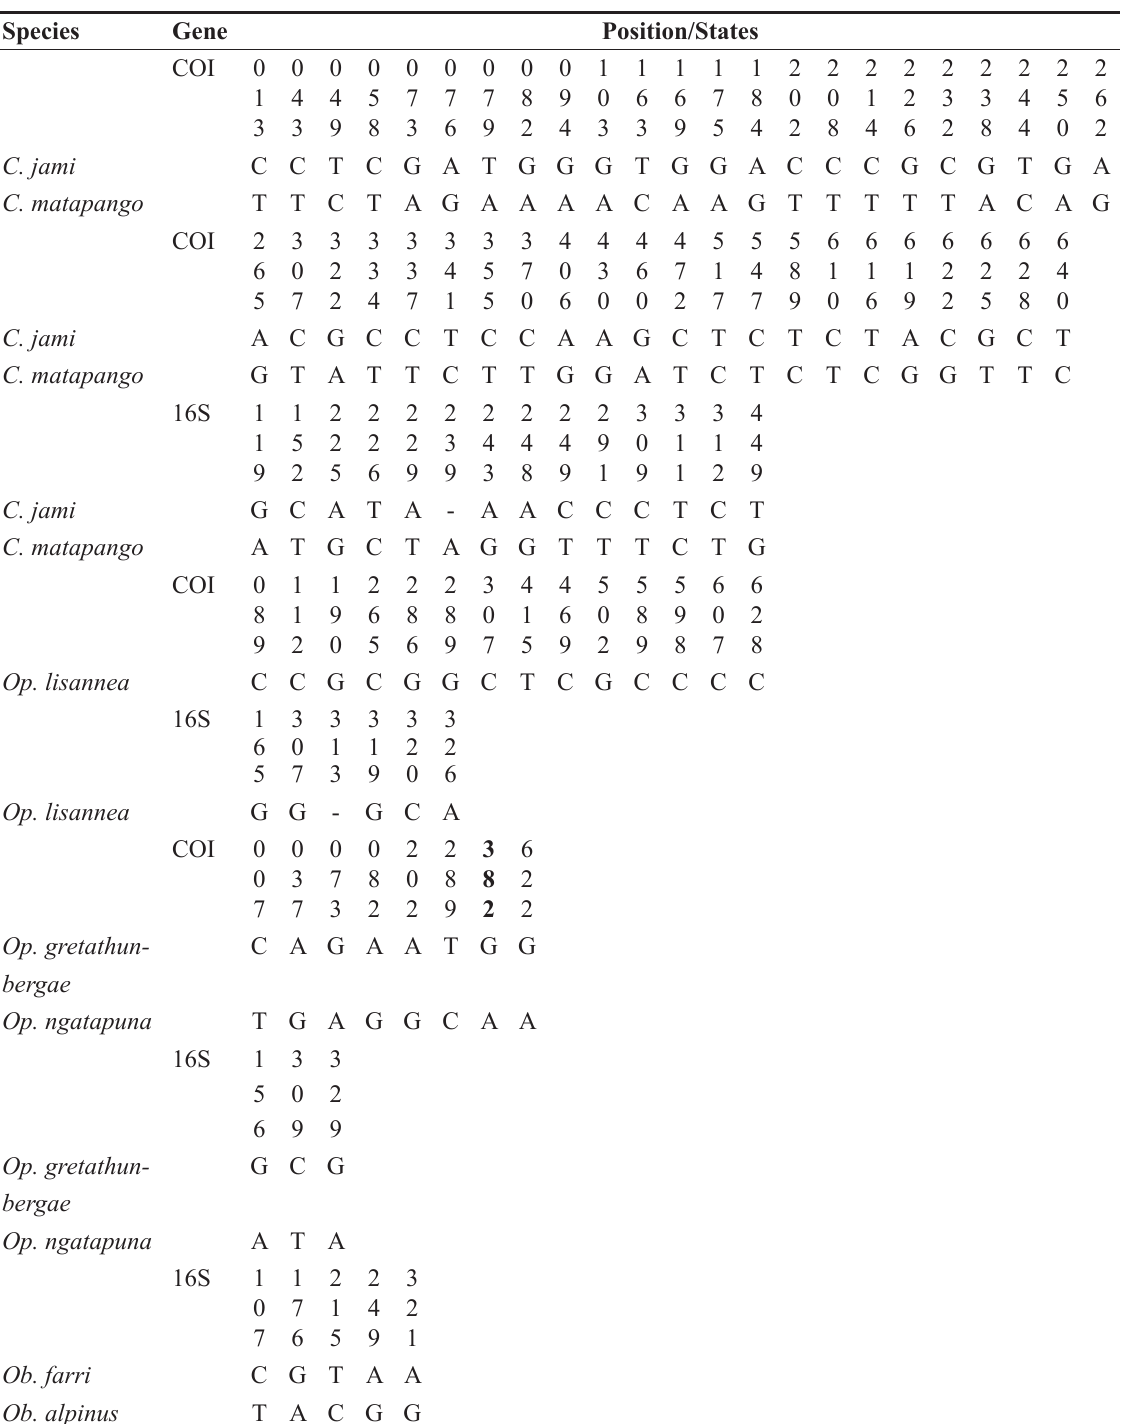
Table 2. Diagnostic alignment positions. All characters are of type 1, i.e., they are fixed in a particular taxon. Positions refer to the alignments of COI and 16S rRNA in Electronic Supplements 1 and 2, respectively. Position 382 in bold is the only diagnostic position for Opacuincola gretathunbergae across all samples of the genus. Therefore, it was also compared to its sister species Op. ngatapuna . In Ob. farri , sequencing of COI